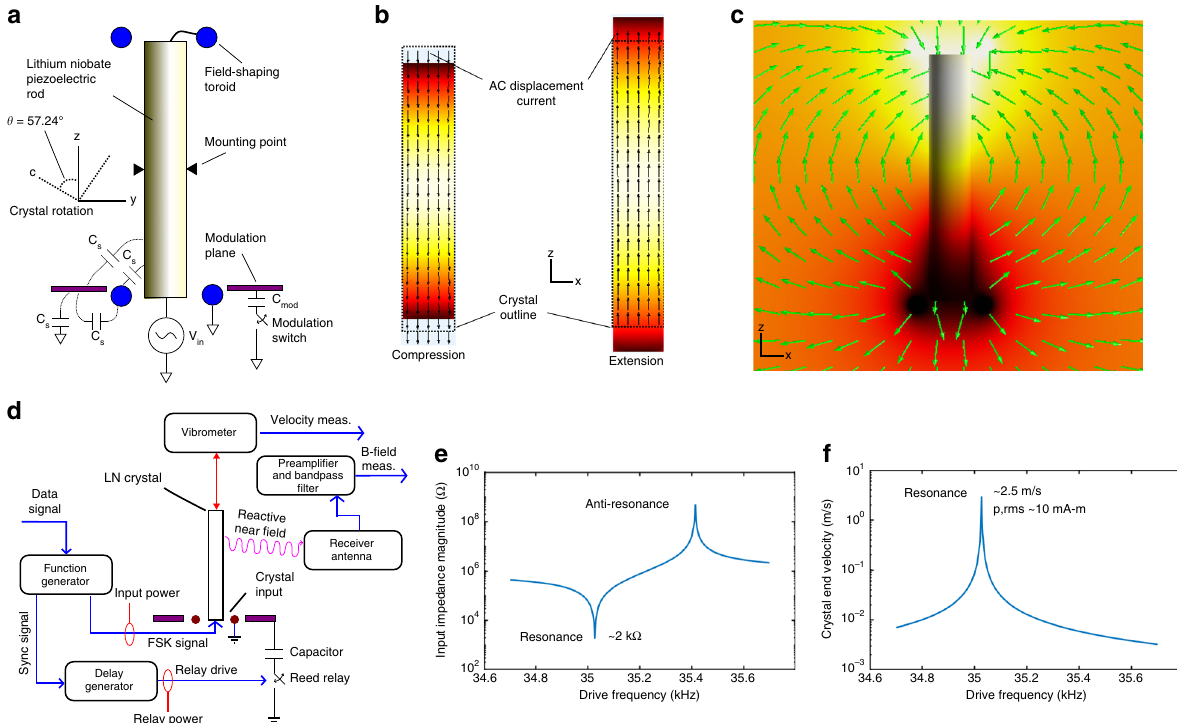
Fig. 1 Illustration of how a piezoelectric resonator can be used as a transmitter. a Schematic of the lithium niobate rod mounting and excitation mechanisms, b Mechanical displacement magnitude (in color, magnitude exaggerated for clarity) and the induced electric displacement vectors (arrows), c Electric potential magnitude in color along with electric fi eld vectors, d Electrical schematic of input and output measurements, e Simulated input impedance magnitude versus frequency, f Representative simulations of velocity and electric dipole moments versus frequency